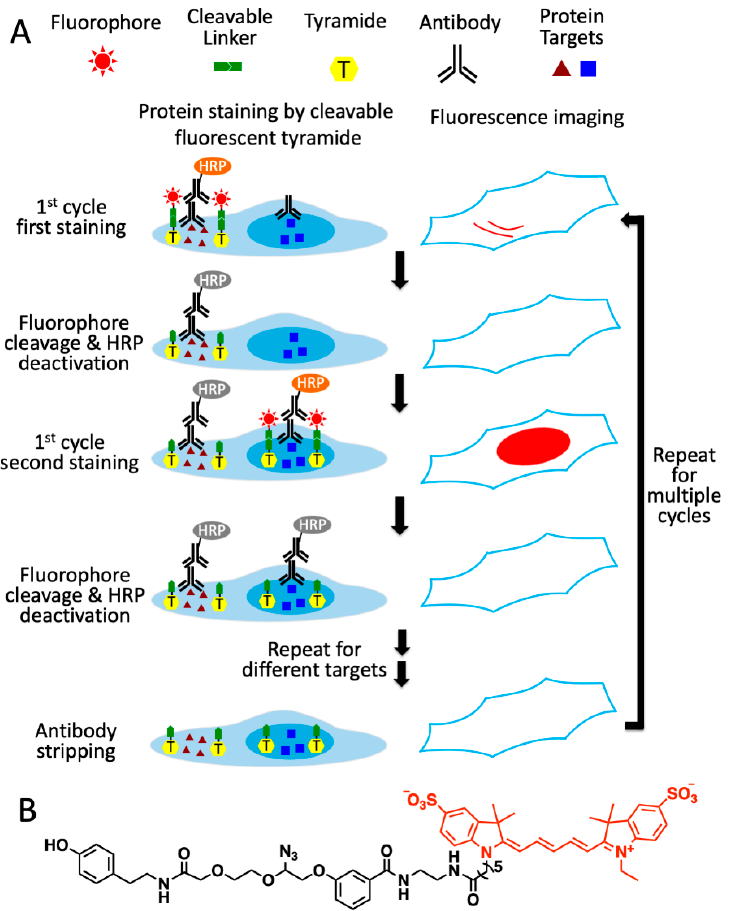
Figure 1. Ultrasensitive and multiplexed protein imaging with cleavable fluorescent tyramide (CFT) and antibody stripping. ( A ) In each cycle, multiple protein targets are first recognized by primary antibodies from different species or of varied immunoglobulin classes. Subsequently, the first target is stained by HRP-conjugated primary or secondary antibodies and CFT. After imaging, the fluorophores are chemically cleaved and HRP is simultaneously deactivated. The processes of protein staining, fluorescence imaging, fluorophore cleavage and HRP deactivation are repeated until every target in the first cycle is stained. Finally, all the antibodies are stripped to initiate the next cycle. Through reiterative analysis cycles, a large number of distinct proteins can be quantitatively profiled in single cells in situ. ( B ) Structure of CFT, tyramide-N 3